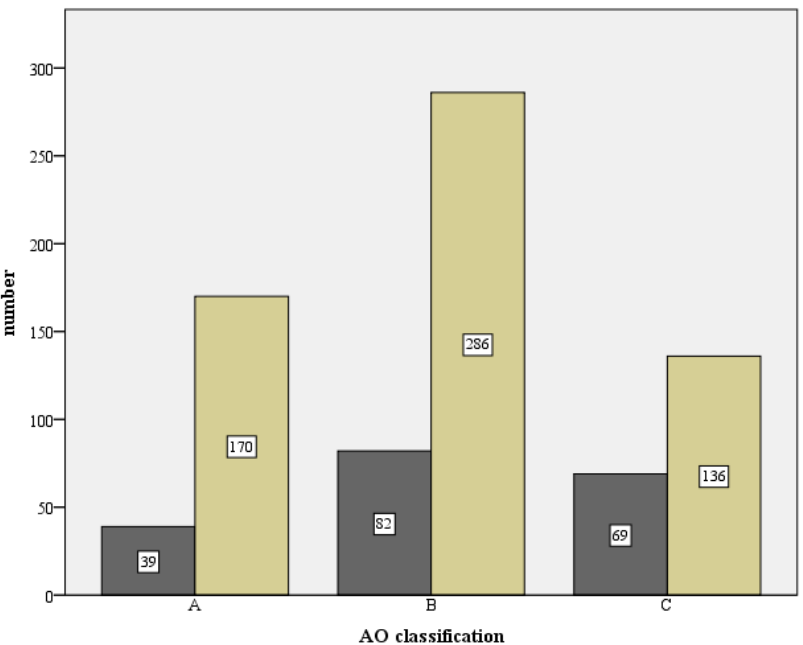
Figure 26. Comparison of the number with complications (dark) and without complications (light) in relation to the respective fracture type, based on the AO classification (X-axis: AO classification, Y-axis: